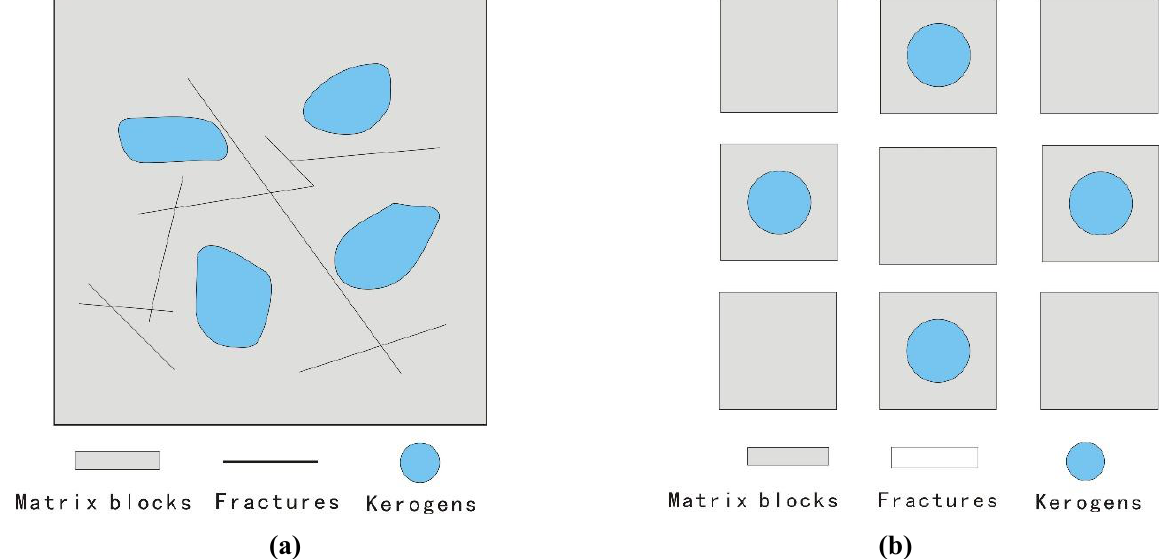
Figure 5—The second type of triple porous media (S-TPM). Real physical model. (b) Ideal physical